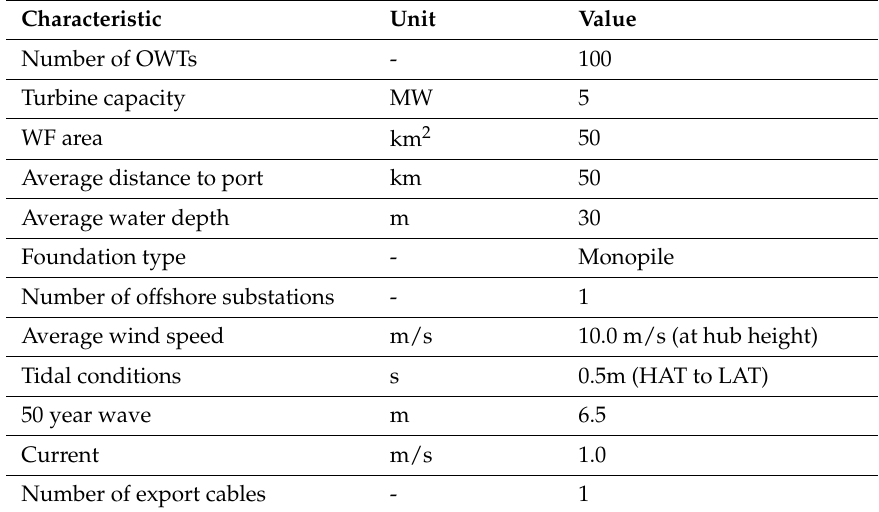
Table 4. WF baseline scenario and Environmental and Operational Conditions (EOCs).